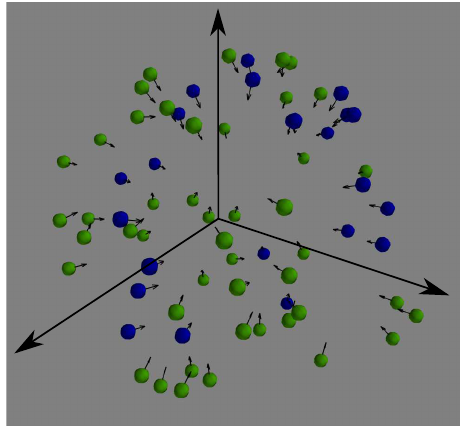
Figure 6. Control points extracted from three different orientations, where N points have a 2D normal vector (green) and M points with 3D normal vector